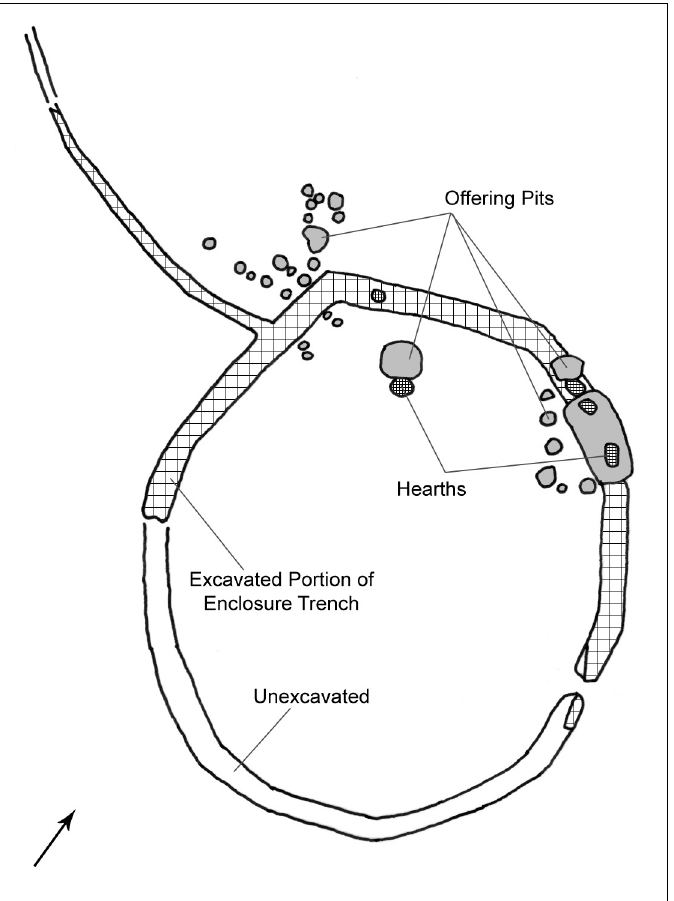
Figure 3: The circular enclosure (after Brunaux 2004, fi g.